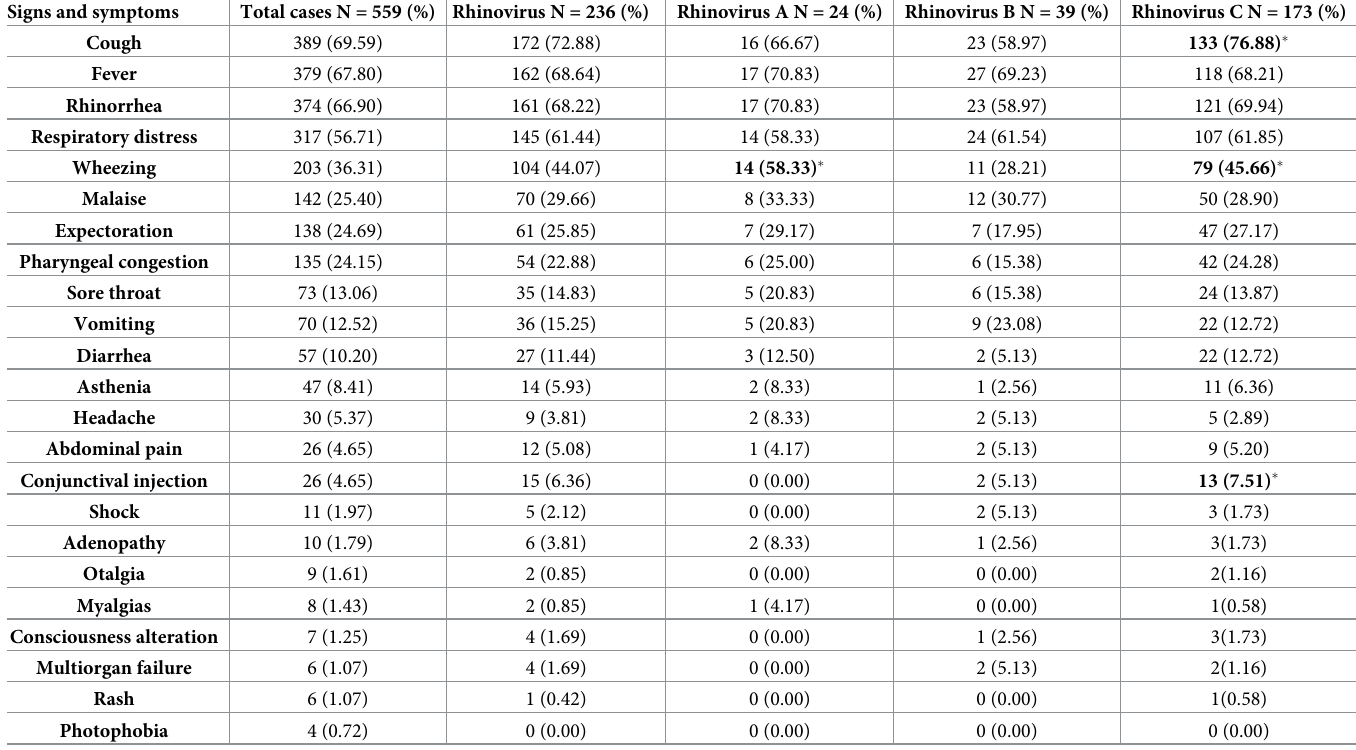
Table 2. Clinical characteristics of pediatric patients with clinical diagnosis of ARI and rhinovirus infection. Signs and